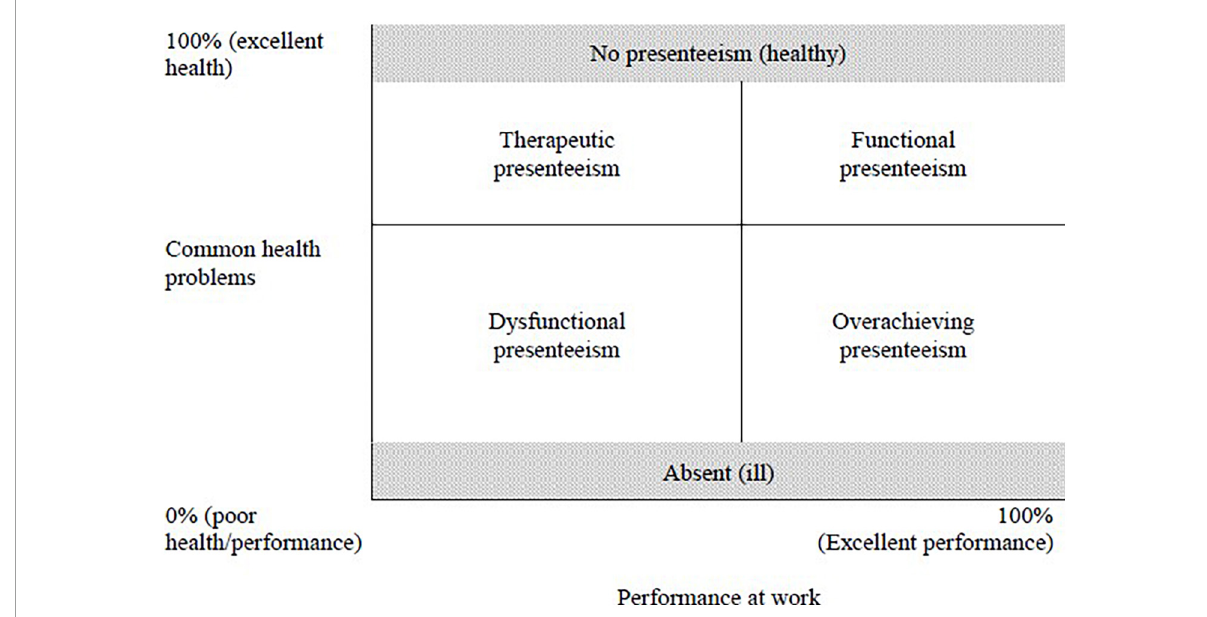
FIGURE1 Typology of presenteeism as a function of health and performance. Reproduced from Karanika-Murray and Biron (2020), with permission from SAGE